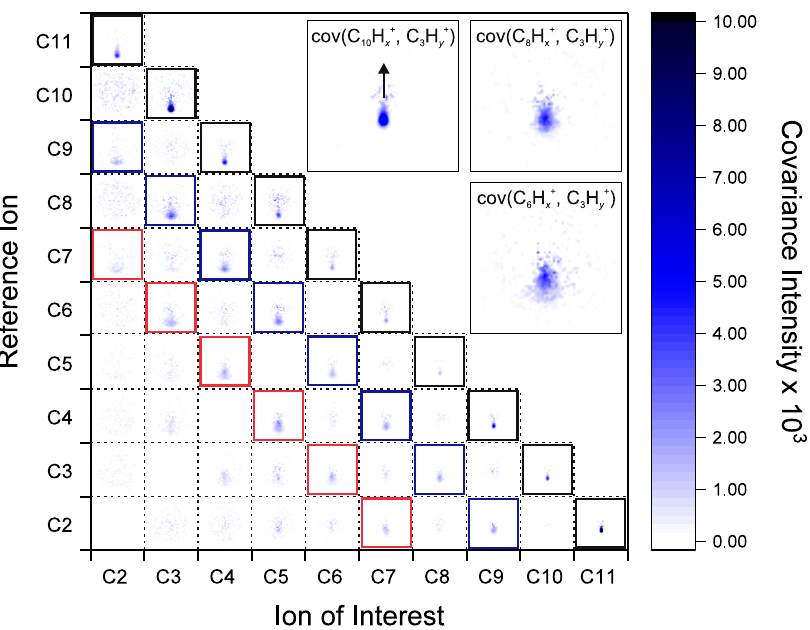
Fig. 3 Full recoil-frame covariance map images. The covariance map images between all ion species produced from FLU. Axis labels refer to the number of carbons in the monocationic species and omit the number of hydrogen atoms. Fragment ion pairs that have a total number of carbons greater than that of the parent ion, for example, between C 8 H þ x and C 9 H þ x , show no covariance as they cannot be formed as partners from the same parent molecule; these have been omitted for clarity. Any ion species will also always show covariance with itself (autocovariance), and these entries have also been omitted. Notably, signal in the cells along the main diagonal of the matrix (highlighted in black) corresponds to the two-body dissociation pathways from the FLU 2 + ion. In addition, the cells highlighted in blue and red correspond to the dissociation pathways where two and four carbon atoms, respectively, are lost in neutral co-fragments. Inset: expansions for the maps corresponding to cov(C 10 H þ x , C 3 H þ y ), cov(C 8 H þ x , C 3 H þ y ), cov(C 6 H þ x , C 3 H þ y ) showing increased blurring as more carbon atoms are lost in neutral co-fragments. The black arrow indicates the direction of the reference ion in all covariance